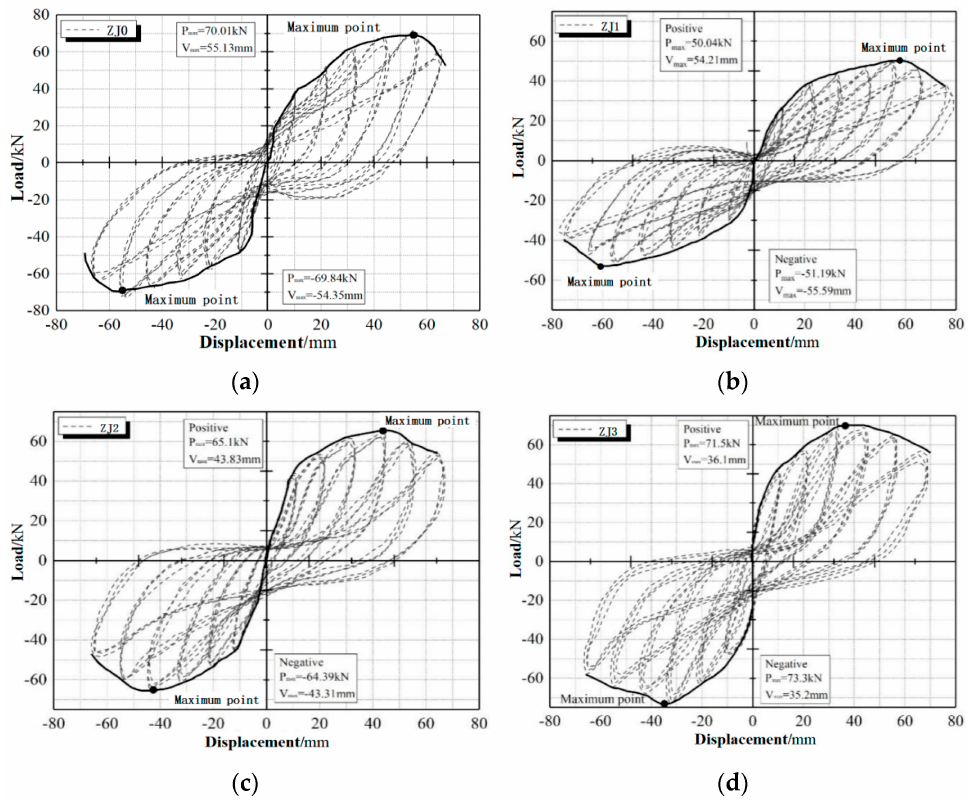
Figure 5. Hysteresis curves and skeleton curves of the specimens: ( a ) ZJ0; ( b ) ZJ1; ( c ) ZJ2; ( d ) ZJ3.